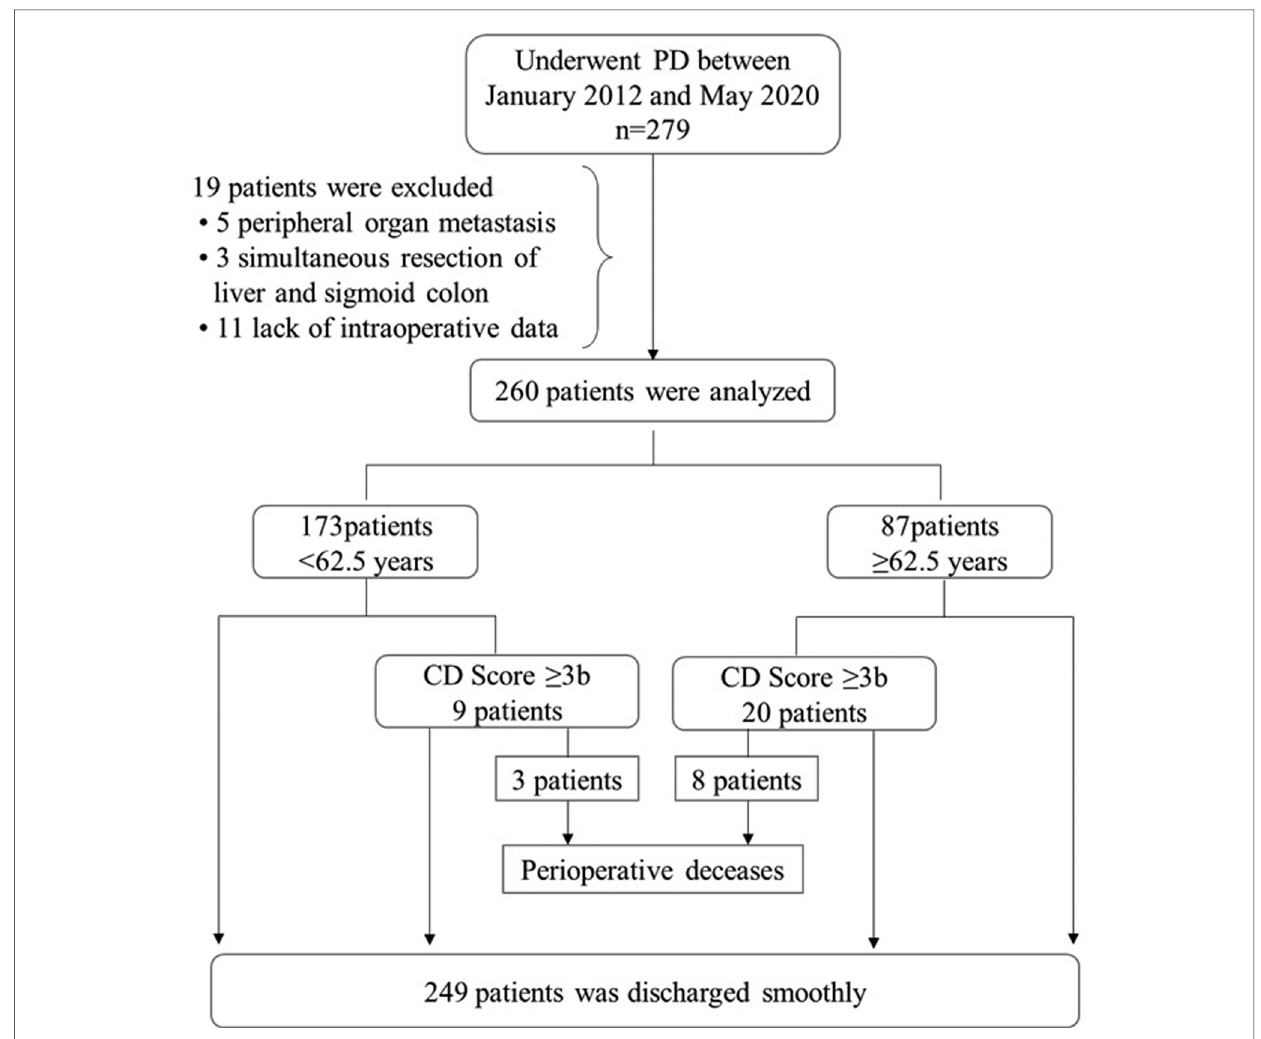
FIGURE 1 Inclusion, exclusion and outcomes of patients. CD Score, Clavien-Dindo Score; PD,